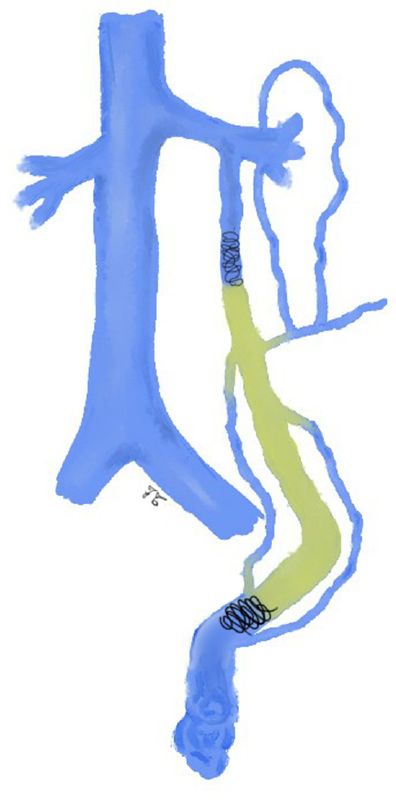
Figure 3. Drawing shows spermatic vein embolization with sclerosing agent: the sclerosant is administered through a catheter whose tip is placed in the most distal part of the ISV, at the level of the sacroiliac joint. Additional coils are deployed at the proximal part of the spermatic vein according to the sandwich technique.